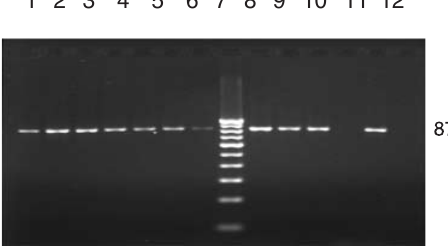
Lane M: 100 bp ladder Lane 1 to 10 samples positive for T. orientalis